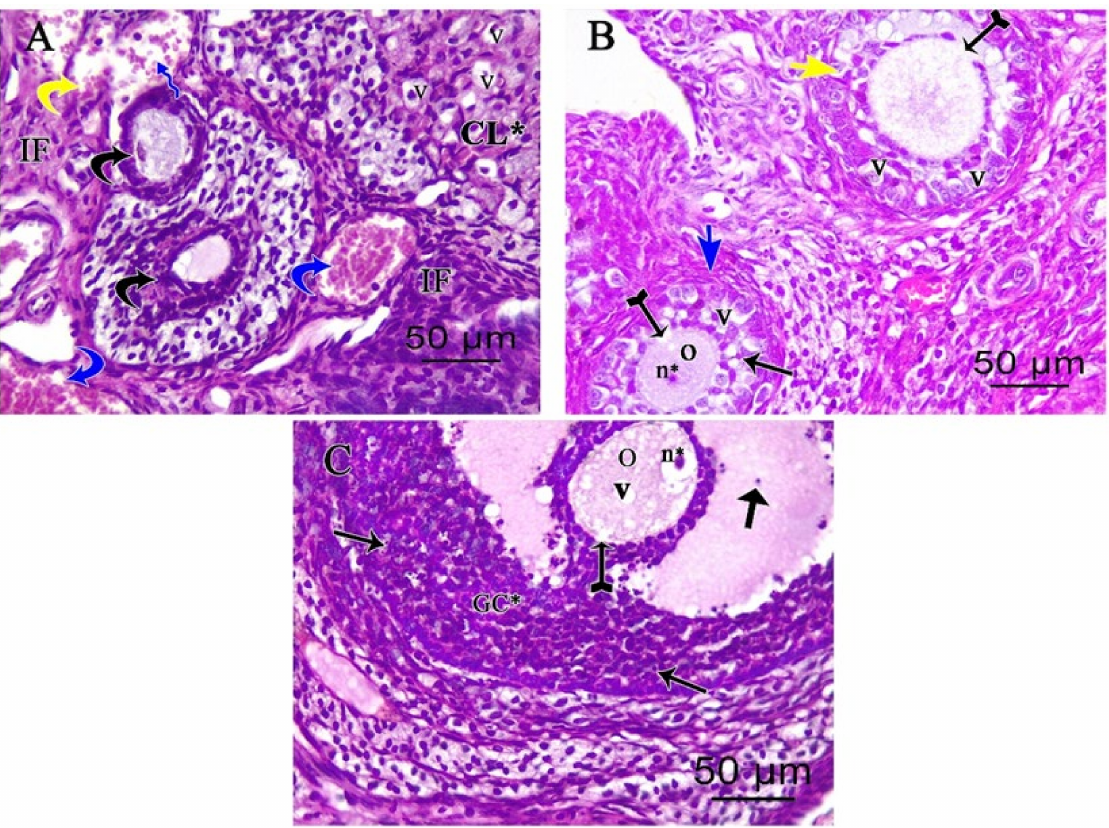
Figure 3. Photomicrographs of (H&E × 400) stained ovarian sections of cisplatin-treated group showing ( A ) degenerating follicles (black curved arrows), dilated congested (blue curved arrows), and ruptured (blue zigzag arrow) blood vessels. Hemorrhage (yellow curved arrows), inflammatory infiltrate (IF), and corpus luteum (CL*) with cell vacuolations (v) are also seen. ( B ) Degenerated multilaminar primary follicle (short blue arrow) with oocyte having pyknotic nucleus (n*), ruptured faint zona pellucida (tailed arrow), and granulosa cells with vacuolation (v) and pyknotic nuclei (thin arrow). A secondary follicle (short yellow arrow) with ruptured faint zona pellucida (tailed arrow) and vacuolated (v) disorganized granulosa cells was observed. ( C ) Degenerating Graafian follicle with an oocyte (O) showing cytoplasmic vacuolations (V) and micronuclei (n*), faint ruptured zona pellucida (tailed arrow), disorganized granulosa cells (GC*) with pyknotic nuclei (thin long arrows). Floating granulosa cells within an antral cavity (thick